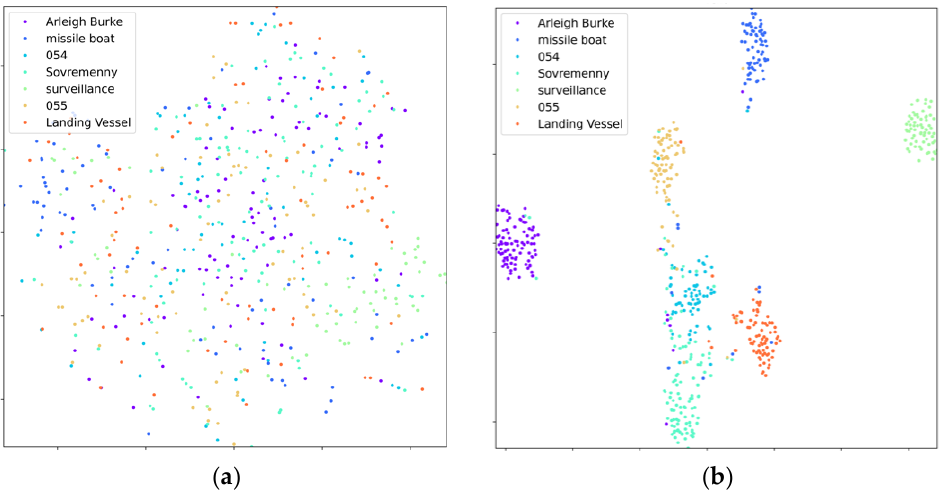
Figure 5. t-sne clustering analysis on the military ship dataset: ( a ) sample of untrained dataset and ( b ) sample of dataset trained by CNN-Swin model.